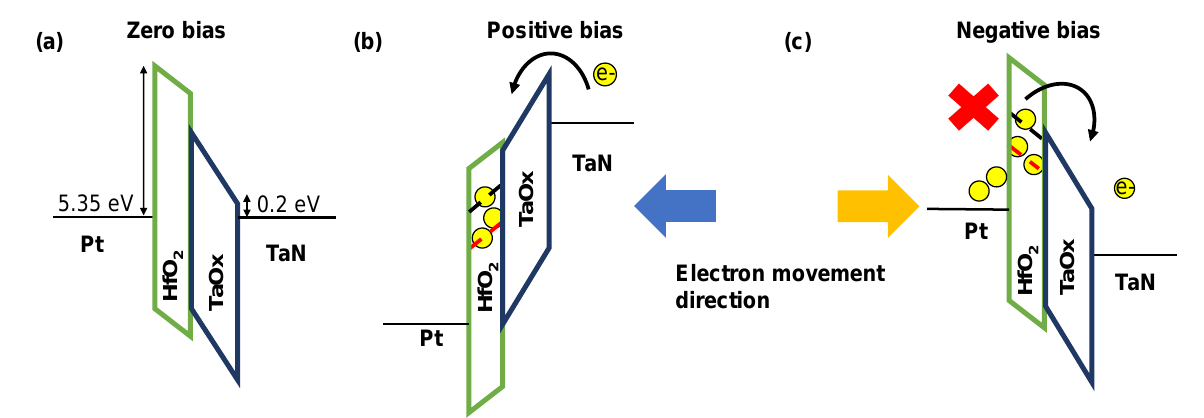
Figure 3. I – V characteristics of four devices: ( a ) PTT, ( b ) PHTT3, ( c ) PHTT5, ( d ) PHTT7. Schemes of the device are shown as the inset.